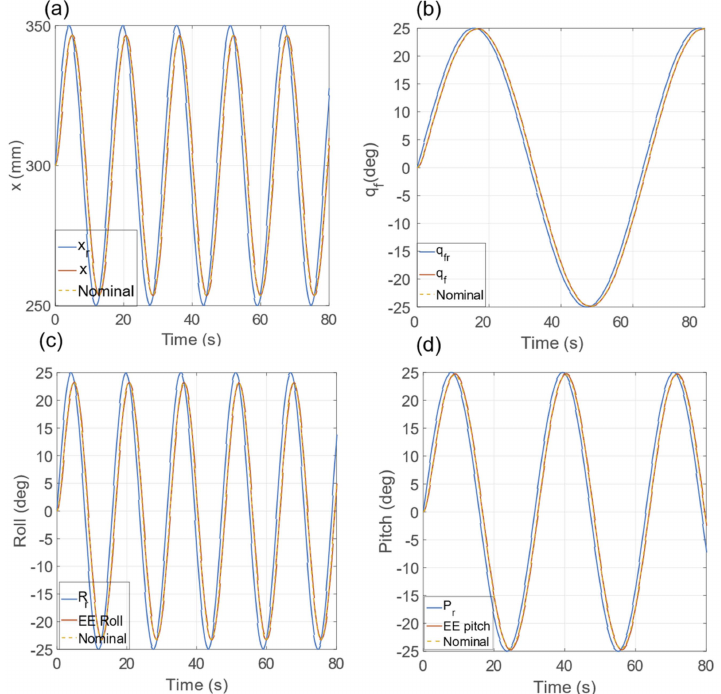
Figure 8. Dynamic evolution of x ( a ), q t ( b ), roll ( c ), and pitch ( d ) variables compared with the nominal dynamics and the relative reference signal for the sinusoidal input.